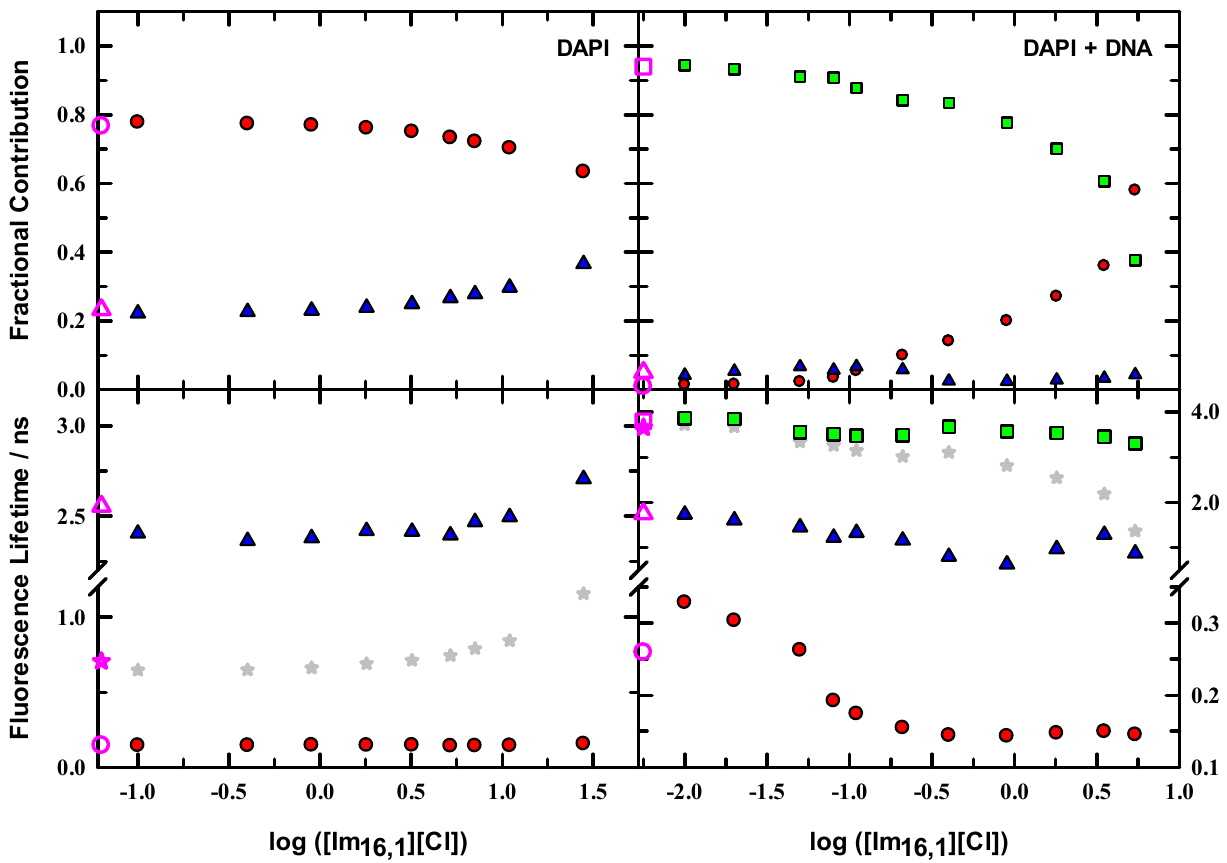
Figure 6. Lifetimes and fractional contributions for DAPI and DAPI + DNA duplex in 10 mM tris buffer at pH = 7.0 as a function of added IL. Left panels: DAPI time constants and associated fractions for a two component fit to the data ( • , (cid:78) ). Right panels: Data for DAPI + DNA duplex for a three component fit to the data ( • , (cid:78) , (cid:4)